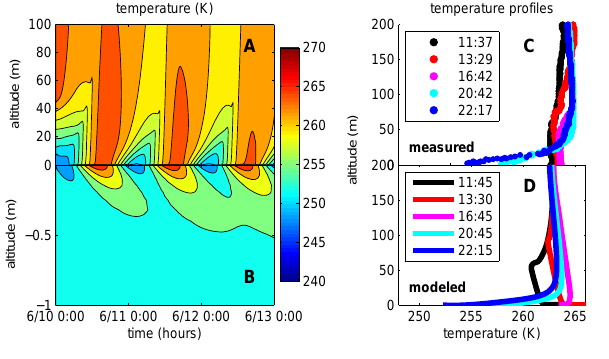
Fig. 4. Modeled temperature evolution of the atmosphere and firn in the upper panels (A) and (B) . Tethersonde measurements (C) com- pared with modeled temperature profiles ( D ).